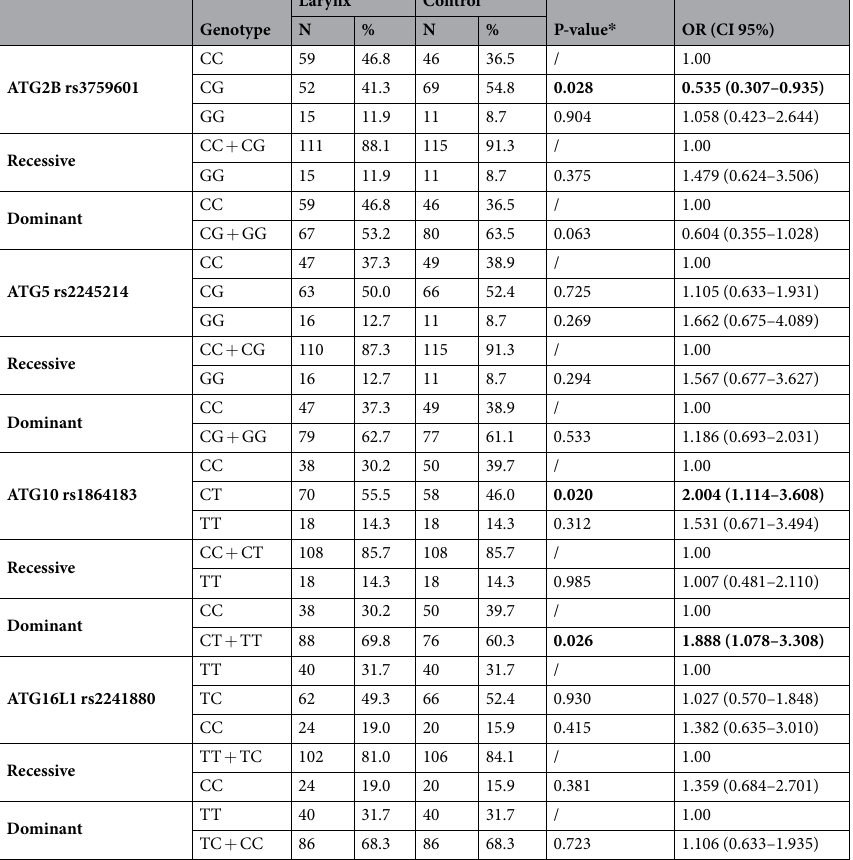
Table 5. Comparative results in selected ATG polymorphism distribution in risk factor-matched laryngeal cancer and controls. * P value & OR adjusted by age. Statistically significant results in